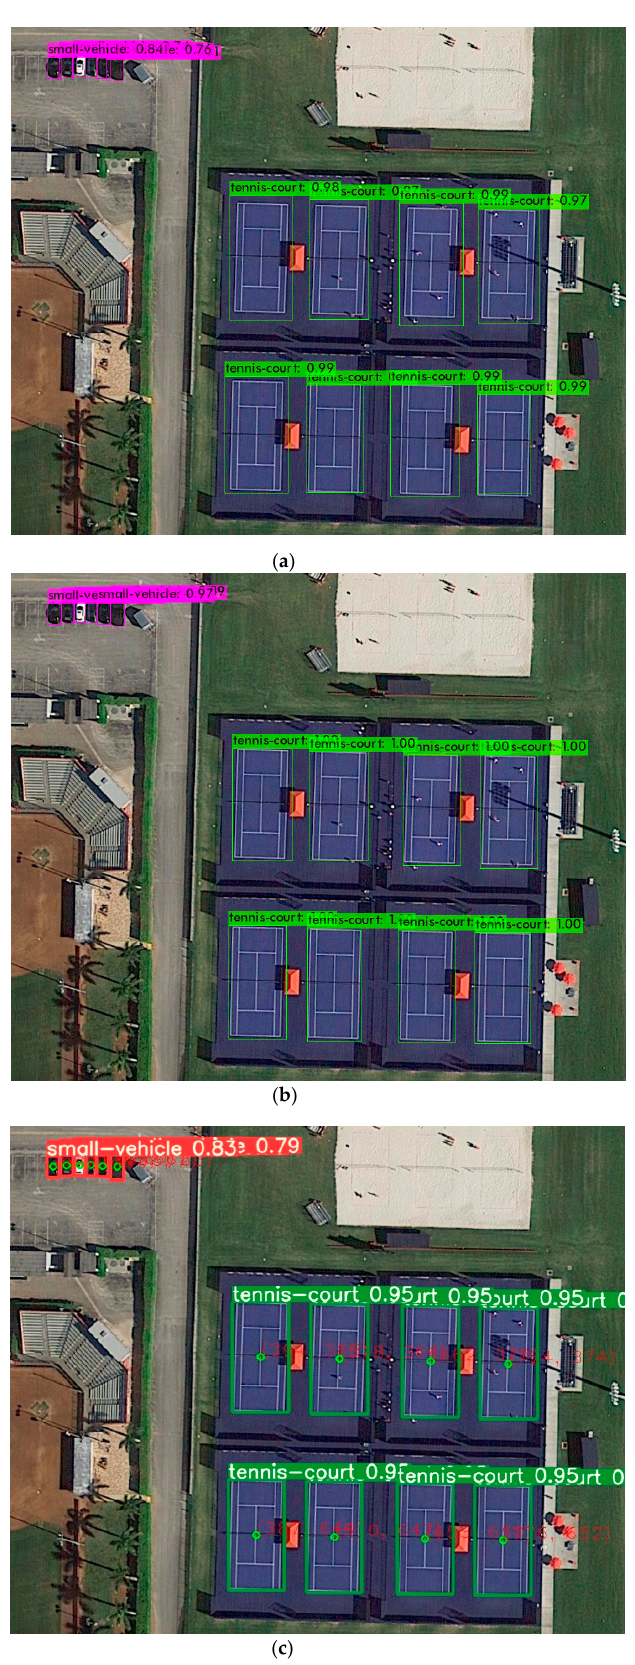
Figure 4. Object detection using YOLO algorithms: ( a ) Object detection using YOLOv3; ( b ) Object detection using YOLOv4; ( c ) Object detection using YOLOv5l.